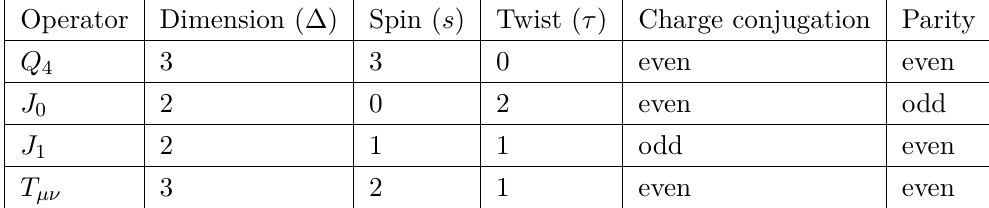
Table 2 . Data of charges and operators of interest in the fermionic